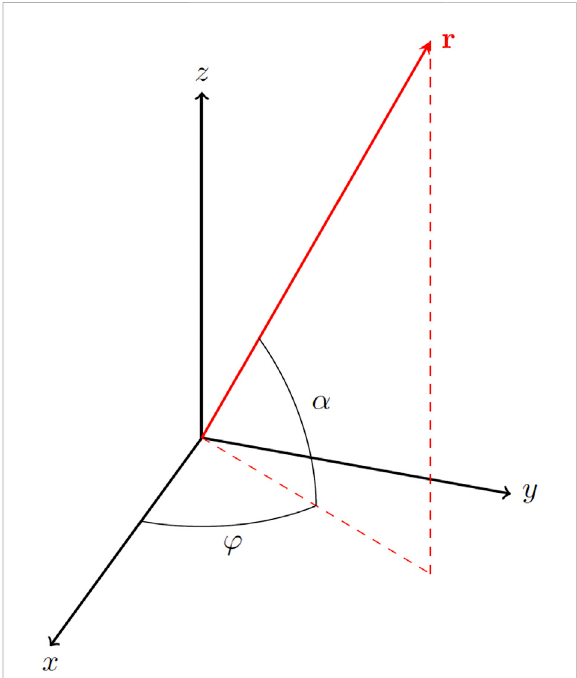
FIGURE 1 3D-PLI coordinate system with fi ber orientation vector r , in- plane angle φ ( direction ) and out-of-plane angle α ( inclination